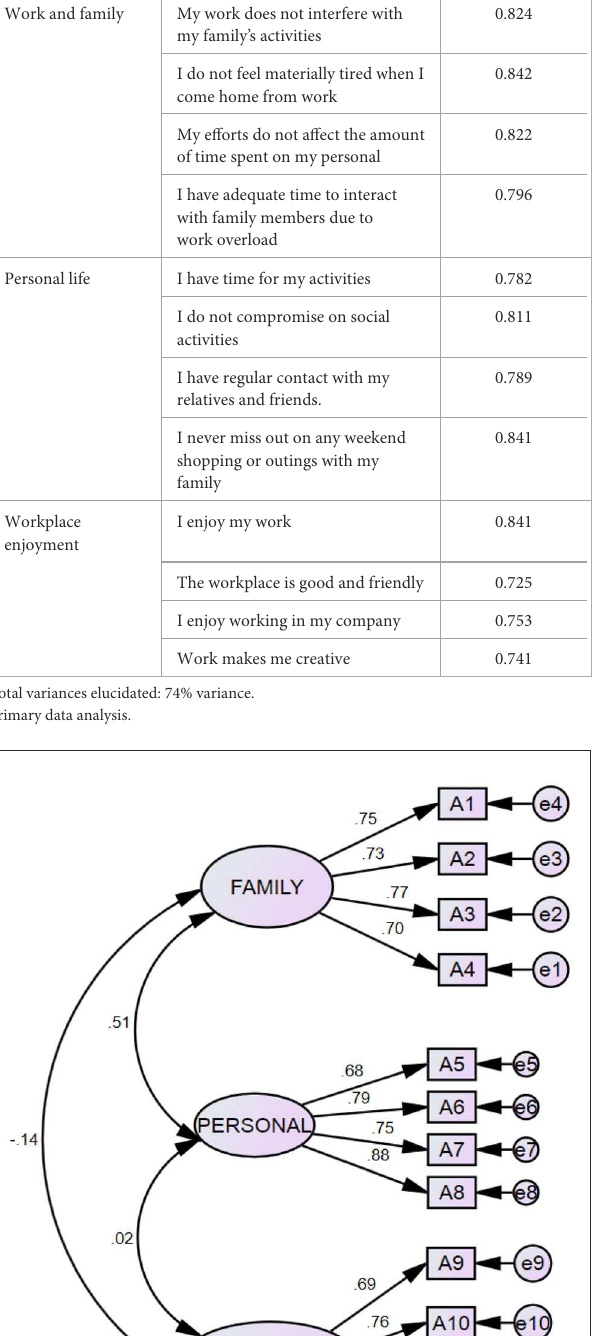
FIGURE1 CFA of work-life balance.